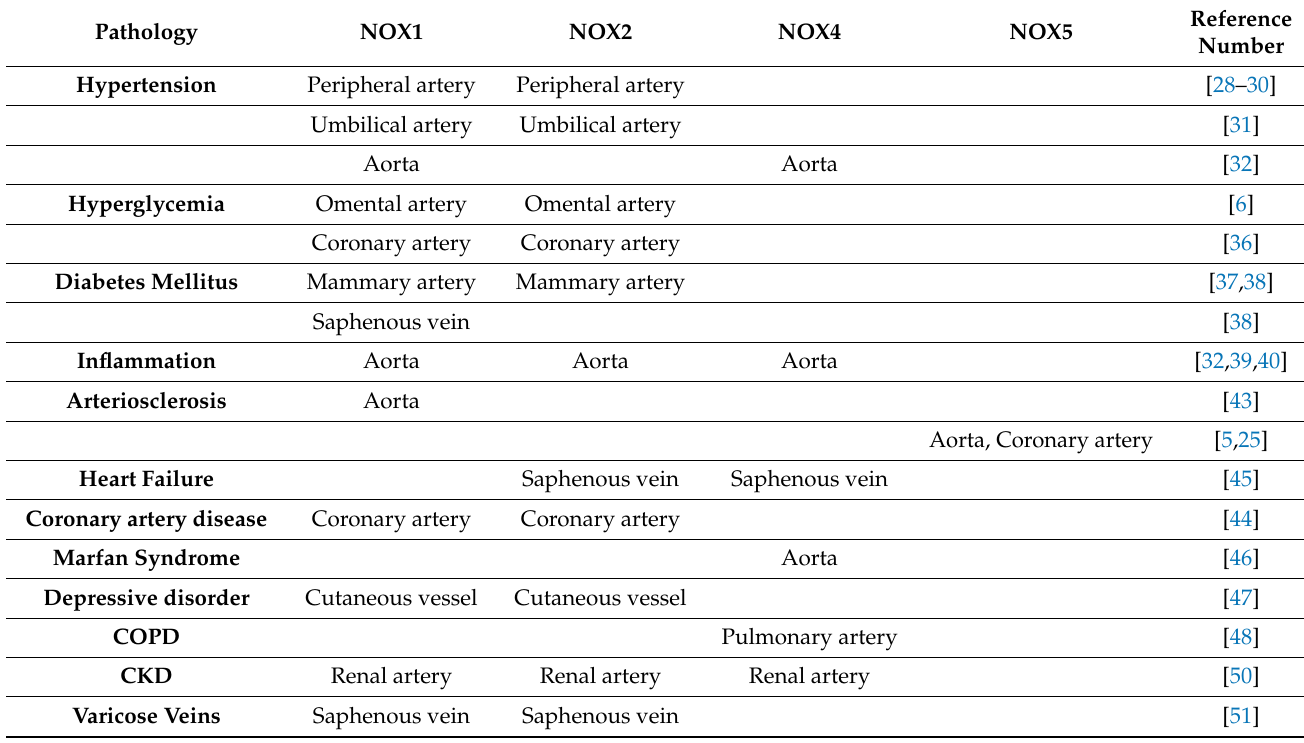
Table 1. Pathology related to oxidative stress induced by NOXs and the human vascular smooth muscle cells’ origin.